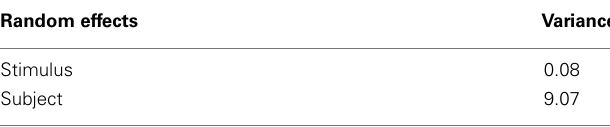
Table 7 | Random effects of model fit only on IB.